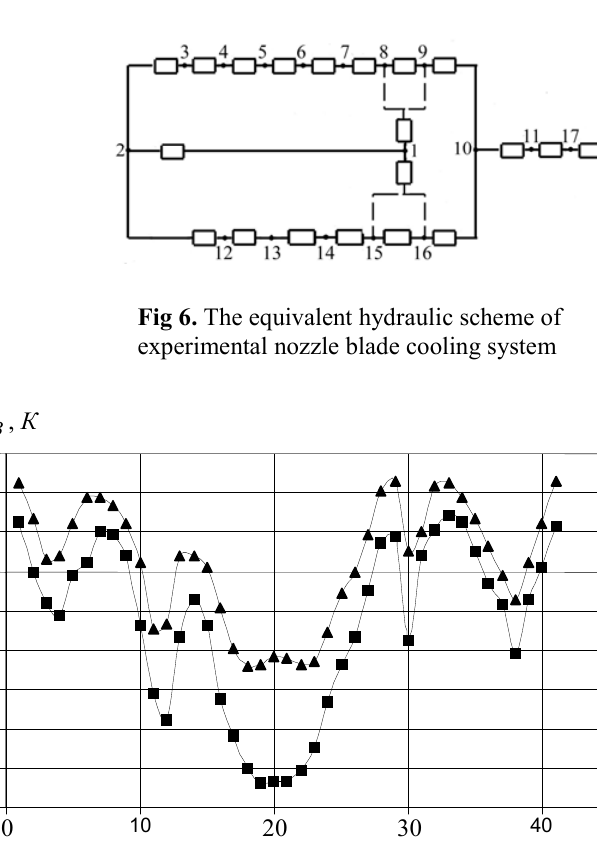
Fig 3. The cascade of profiles of the